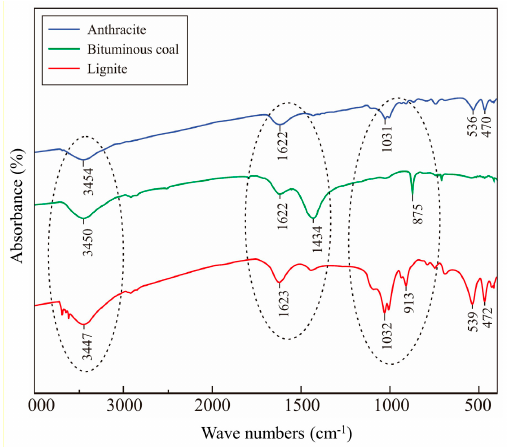
Figure 4. FT-IR spectra of the coal samples.